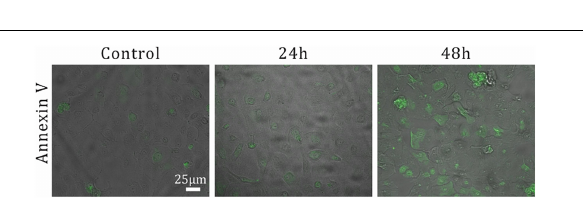
FIGURE 4 | Examination of α VR1 antibody effect on NHBE cells over time. The apoptotic response over time for α VR1 antibody on NHBE cells was investigated as a positive control. 5 × 10 4 NHBE cells per well are seeded in a 96-well plate. Two days after seeding, medium containing 0.66 µ M α VR1 antibody was added, followed by incubation of 24 and 48 h. Next, apoptotic cells were stained using Annexin V (see the section “Apoptosis Quantification”), and imaging of fluorescent immunostaining was